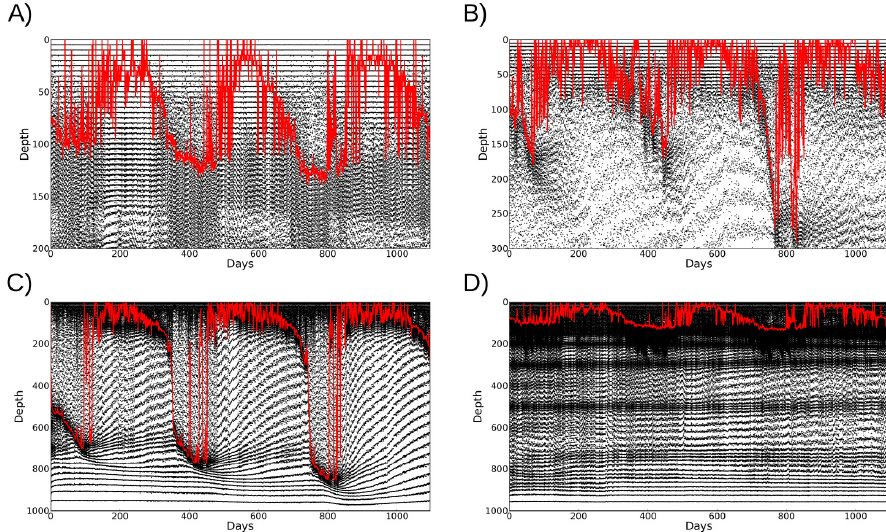
Fig. 10. Representation of the meshes obtained via adaptivity for all stations using the bio and phys metric. A dot is placed on each vertex in the mesh and this is repeated for each output time. Clustering of vertices therefore indicate higher resolution. Station Papa (A) shows reduced resolution under the mixed layer during summer, but high resolution persists for some distance below the mixed layer. Bermuda (B) shows substantial reduction of resolution below the mixed layer, but with the minimum resolution being maintained during the summer in the upper layers. Similarly, India (C) tracks the MLD, with decreased resolution within the mixed layer, whilst maintaining good resolution in the upper portion of the water column. Gradients in density mean that high-resolution zones are maintained at Station Papa (D) at up to 800m